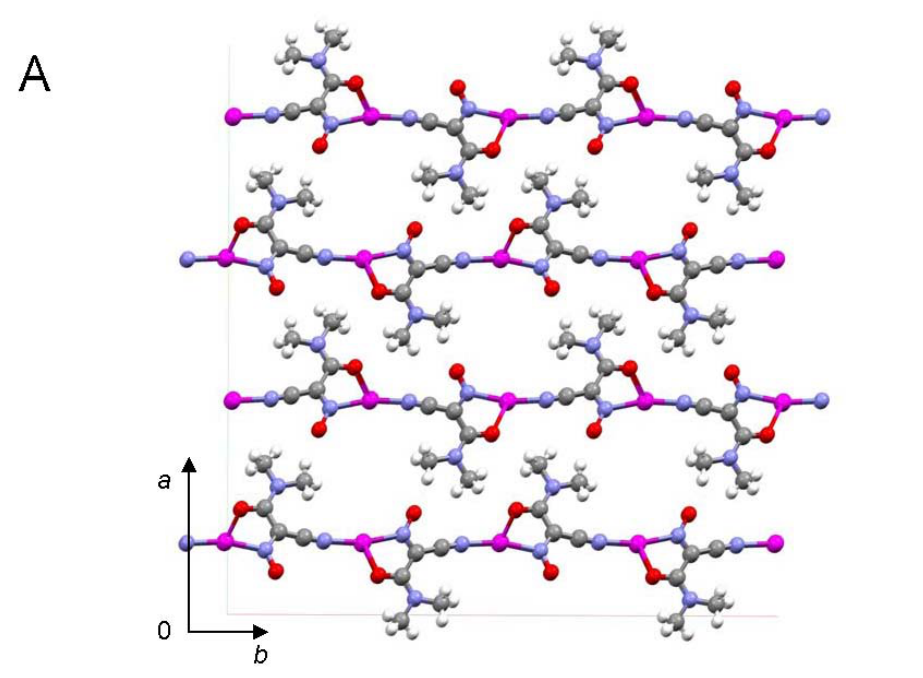
Figure 16. Organization of layered 2D structure of Ag(DCO): view of ten unit cells along c direction showing polymeric motif ( A ), and then view of the same ten unit cells along b ( B ) in which H-atoms are omitted for